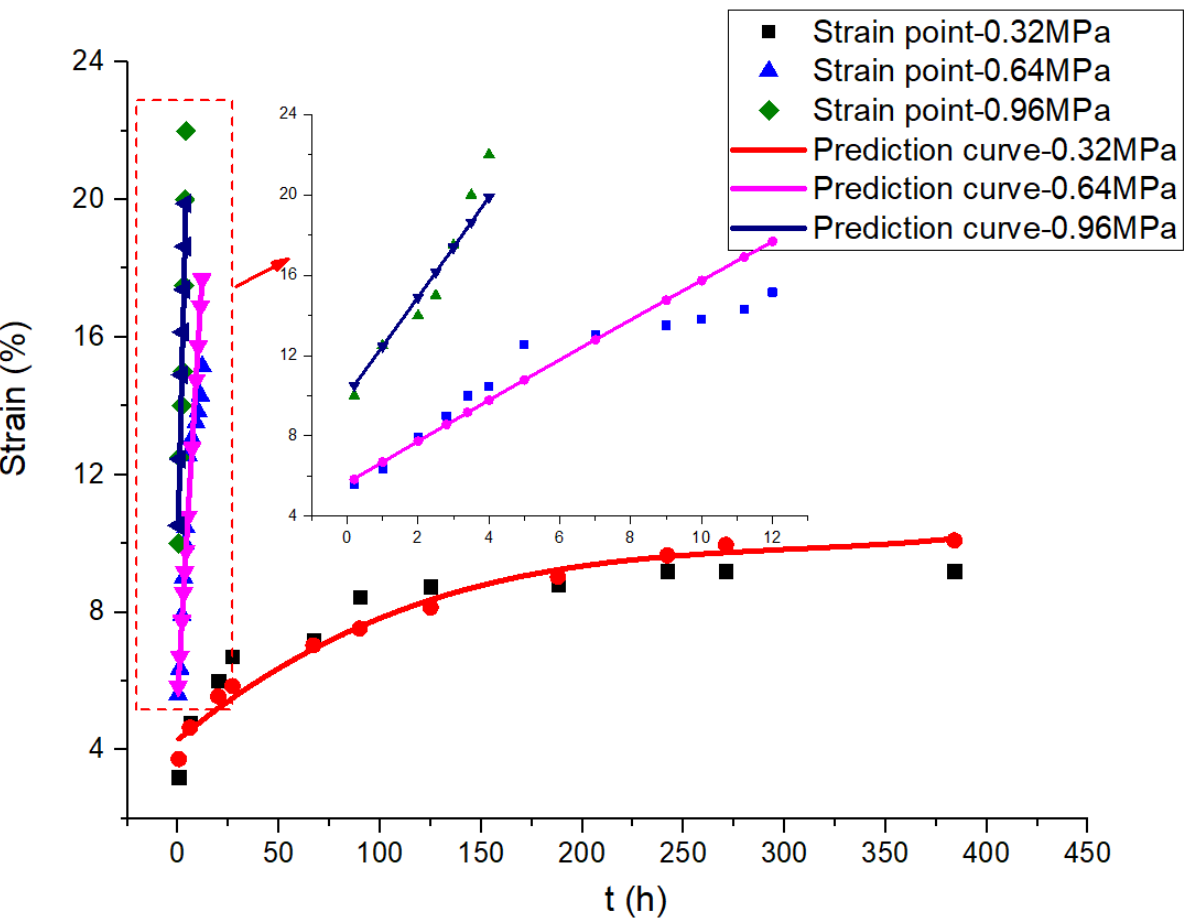
Figure 8. Comparison of strain points and predicted curves of creep in the HTAH environment.